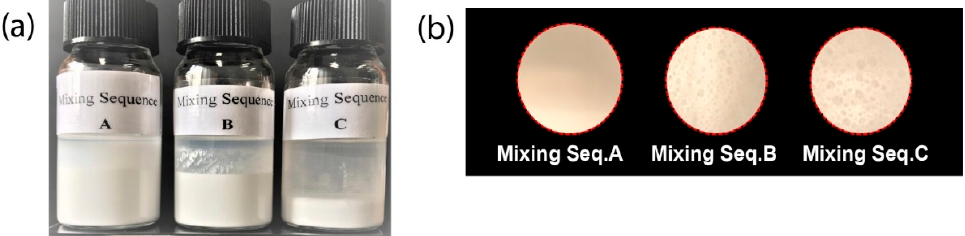
Figure 3. Digital camera images of ( a ) vials illustrating sedimentation of slurries under gravity at 25 °C for 30 days, ( b ) slurry surface showing the effect of mixing sequence on foam formation/bubbles in the slurries with DLSS prepared according to the three mixing sequences.